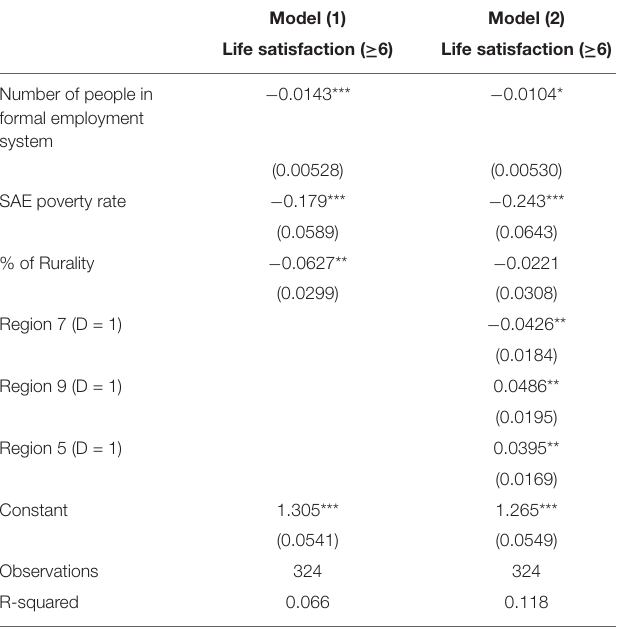
TABLE 7 | SAE for life satisfaction measured as